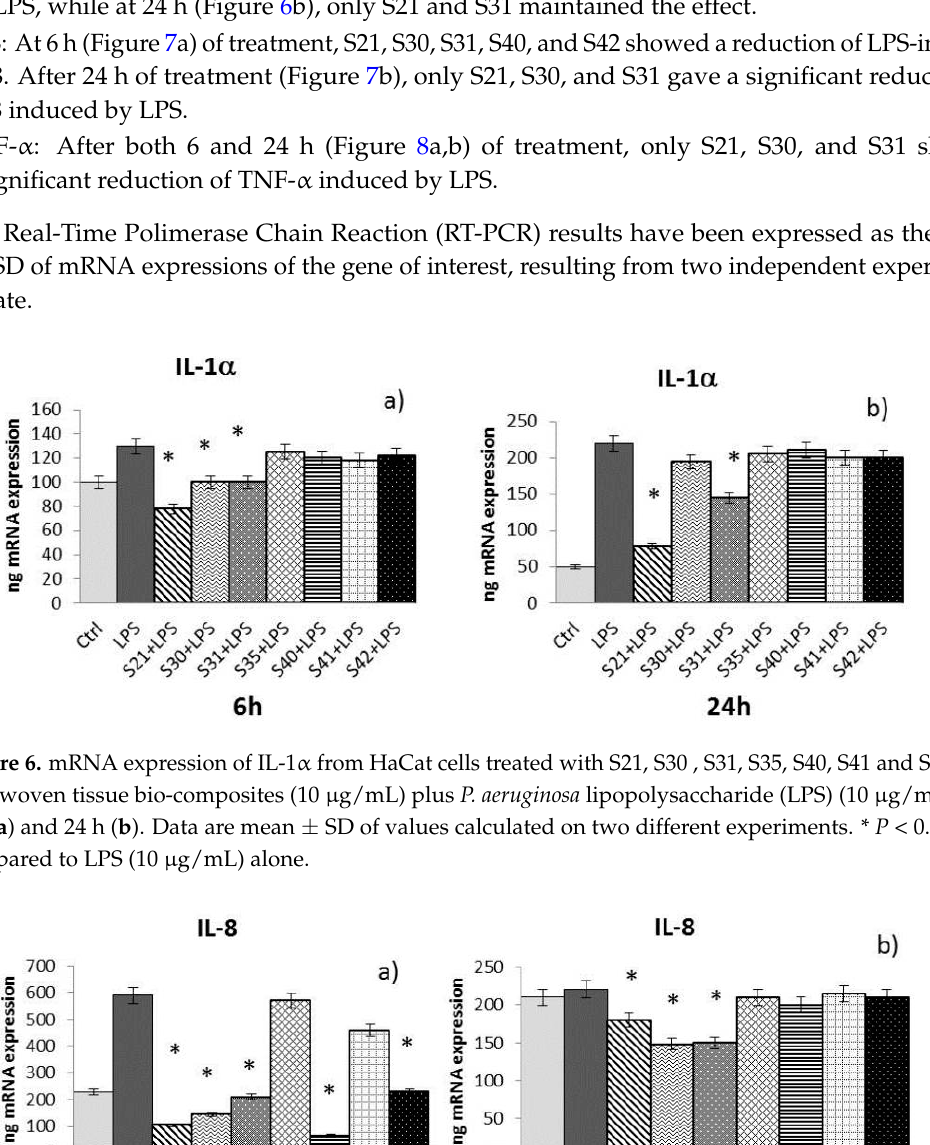
- IL-1 α : At 6 h (Figure 6a) of treatment, only S21, S30, and S31 were able to reduce IL-1 α induced by LPS, while at 24 h (Figure 6b), only S21 and S31 maintained the effect. - IL-8: At 6 h (Figure 7a) of treatment, S21, S30, S31, S40, and S42 showed a reduction of LPS-induced IL-8. After 24 h of treatment (Figure 7b), only S21, S30, and S31 gave a significant reduction of IL-8 induced by LPS. - TNF- α : After both 6 and 24 h (Figure 8a,b) of treatment, only S21, S30, and S31 showed a significant reduction of TNF- α induced by LPS.